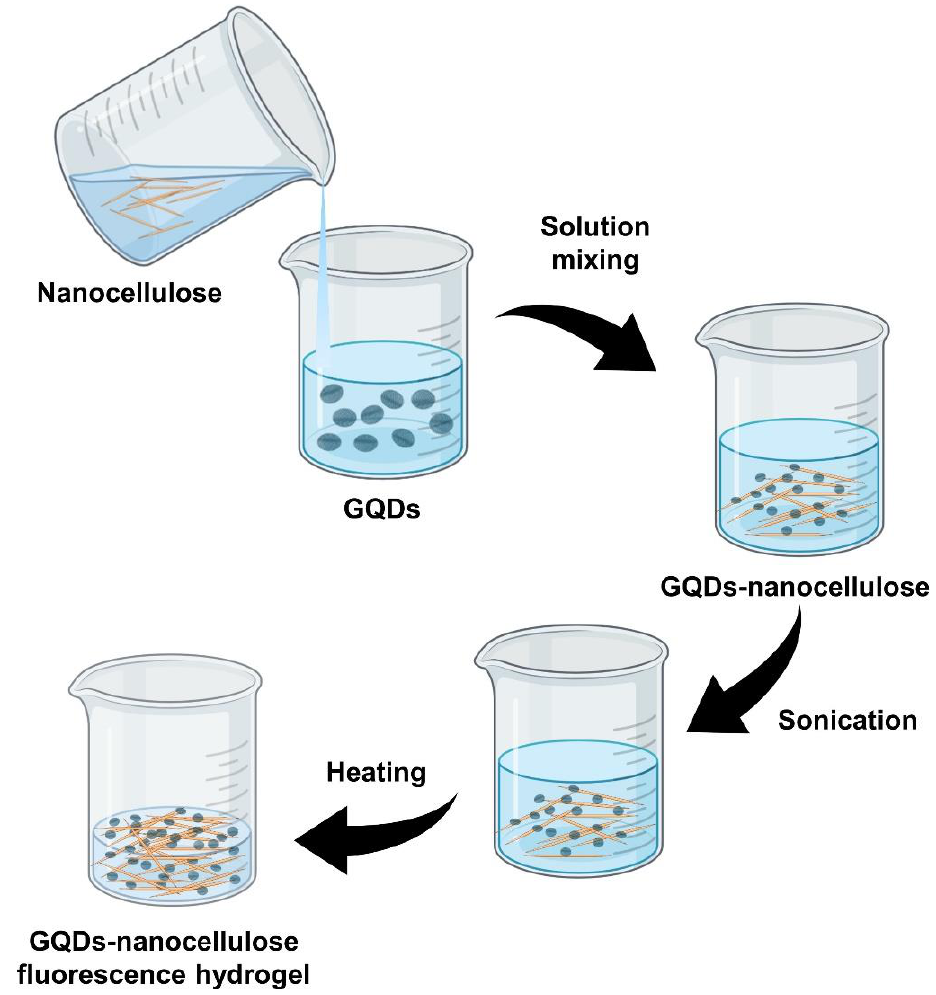
Figure 3. Preparation of GQDs–nanocellulose fluorescence hydrogel via solution mixing.